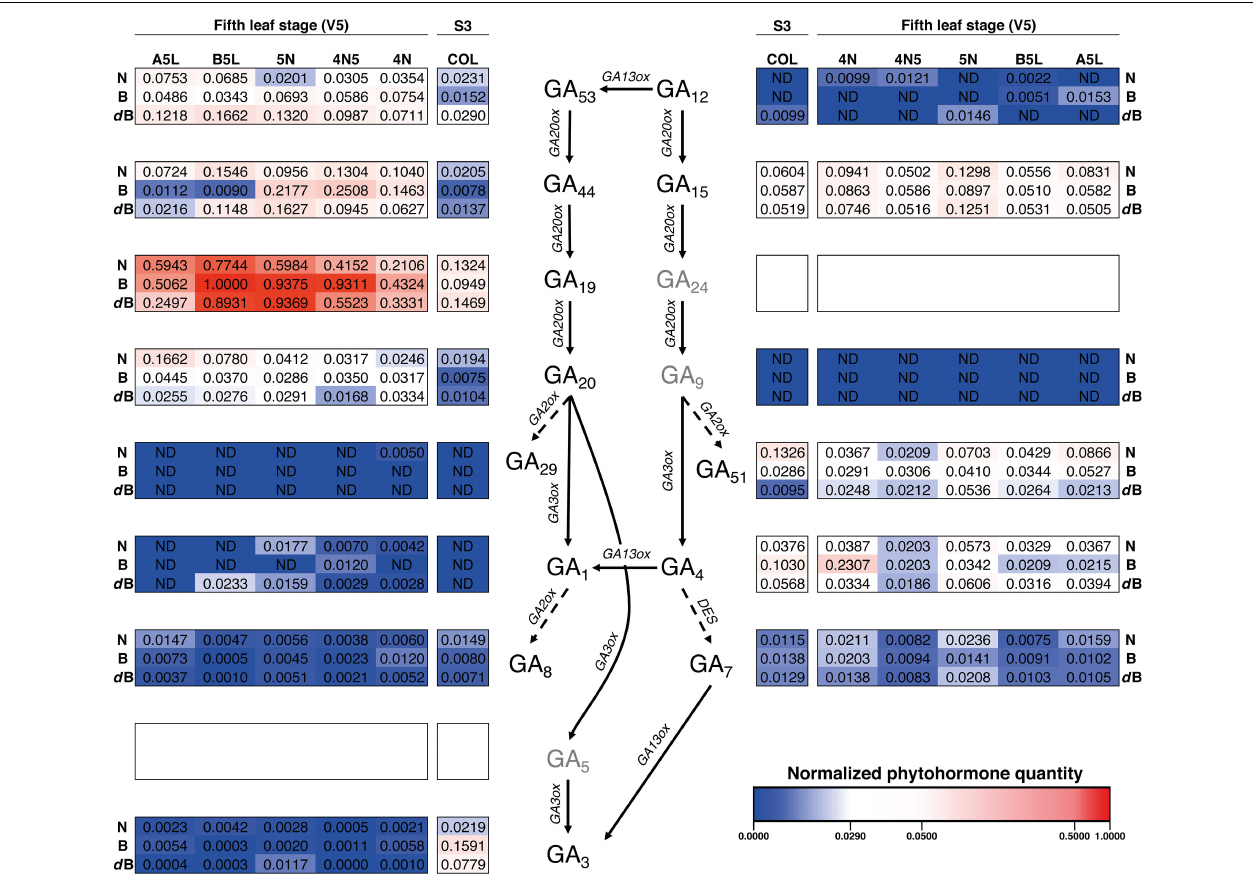
FIGURE 6 | Heatmap of the hormone profiling of the three Mediterranean japonica rice varieties in the stages S3 and V5. Normalized phytohormone quantity scale is shown at the lower right of the image and corresponds to the mean of 3 replicates. Three phytohormones (GA 5 , GA 9 , and GA 24 , in gray) were not analyzed, ND, not determined. N, NRVC980385; B, Bomba; d B, dwarf -bomba; COL, coleoptile; 4N, 4th node; 4N5, internode between 4th and 5th node; 5N, 5th node; B5L, basal part of the 5th leaf; A5L, apical part of the 5th